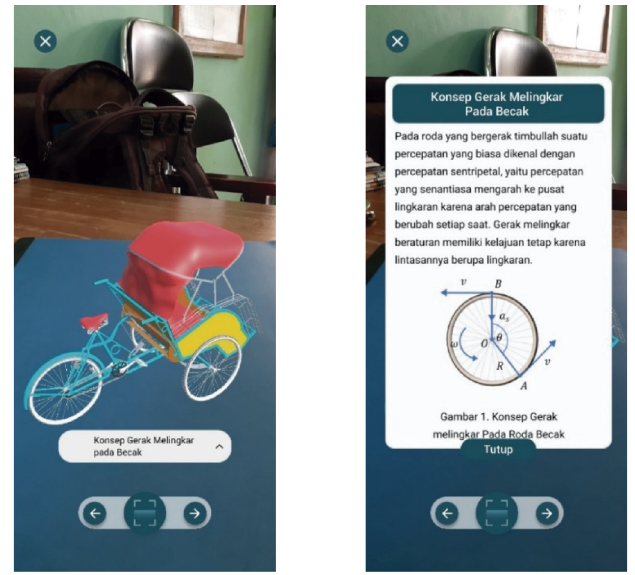
Figure 8. Augmented reality-assisted physics e-module based on